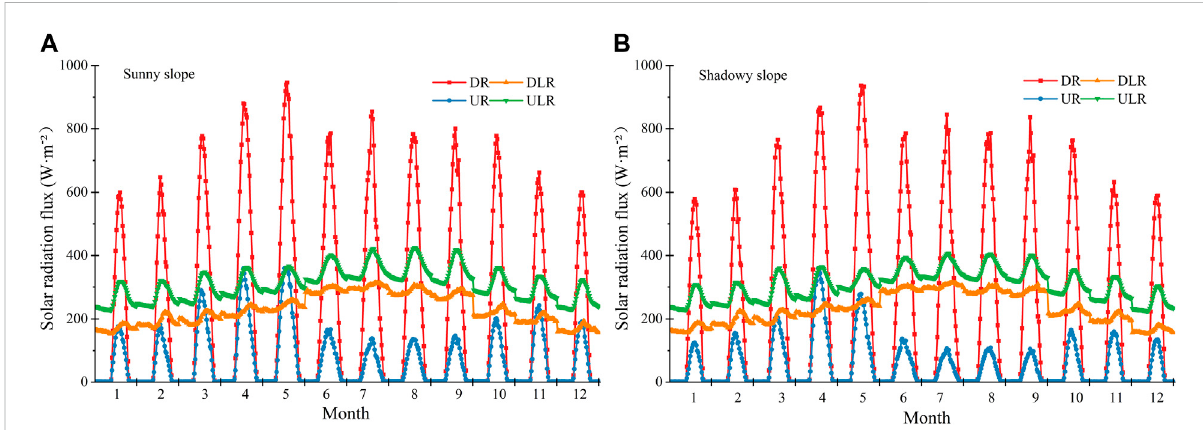
FIGURE 2 Characteristicsofmonthly meandaily variation ofsurfaceradiation fl uxbalanceon thesunny (A) andshadowy (B) slopes fromOctober 2019 to October